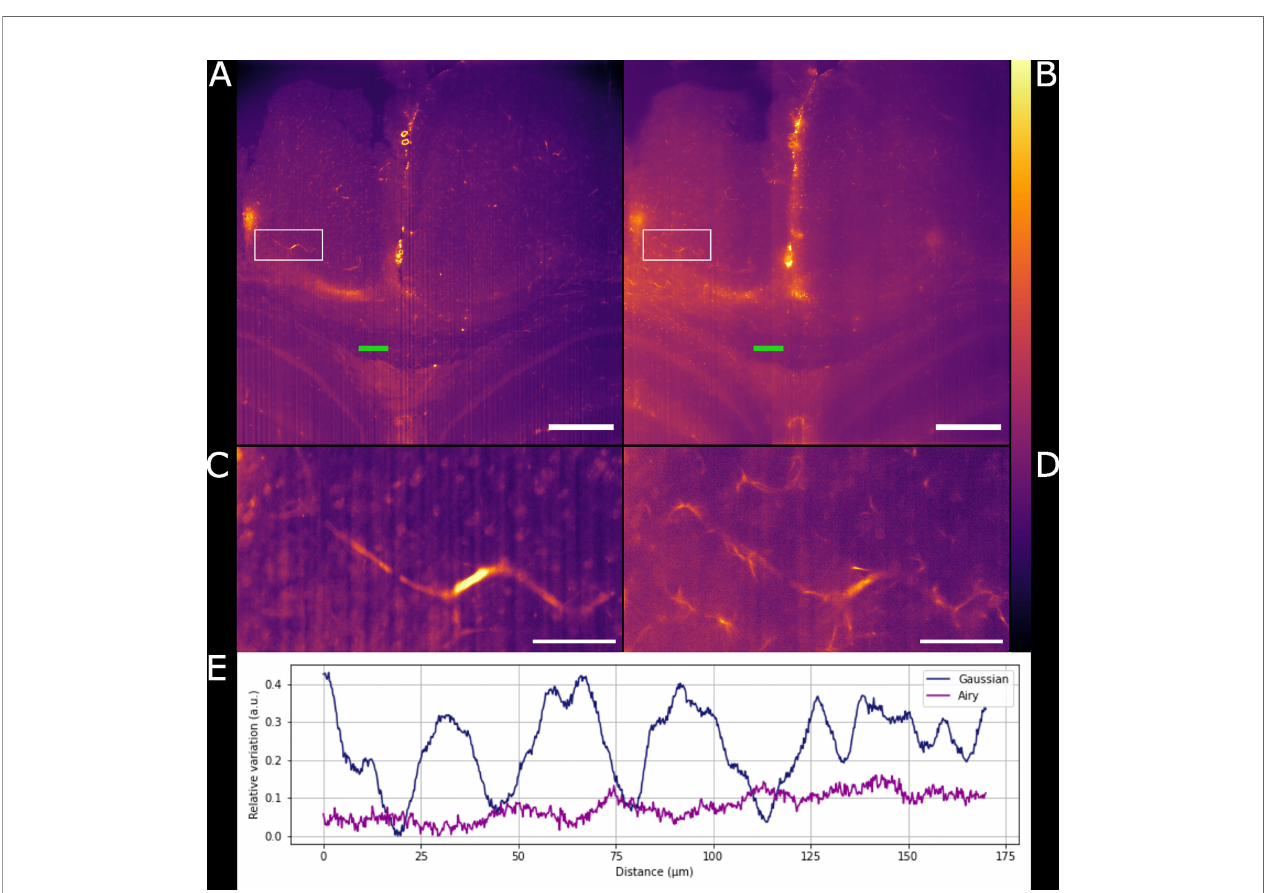
FIGURE 3 | Comparison between Gaussian light-sheet and Airy light-sheet images. (A) Single optical section of the same infected mouse brain, acquired with the Gaussian light-sheet and (B) the Airy light-sheet setup. The boxed region in (A, B) are magni fi ed in (C) e (D) to highlight the increase in subcellular details obtained with the Airy light-sheet. The look-up table for (A – D) is mpl-inferno. The scale bar is respectively (A, B) 500 µm and (C, D) 100 µm. The images were converted to 8-bit values (0-255). (E) Comparison between the relative variation of the stripes artefact intensity in the central region of the specimen indicated by the green line in panels (A, B)